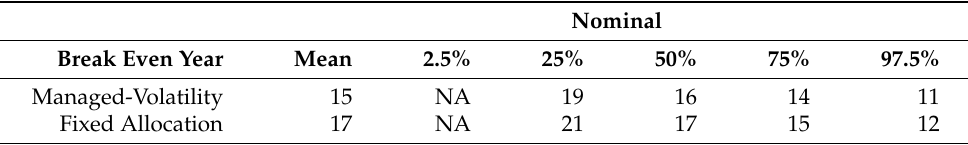
Table 5. Base Case: Break Even